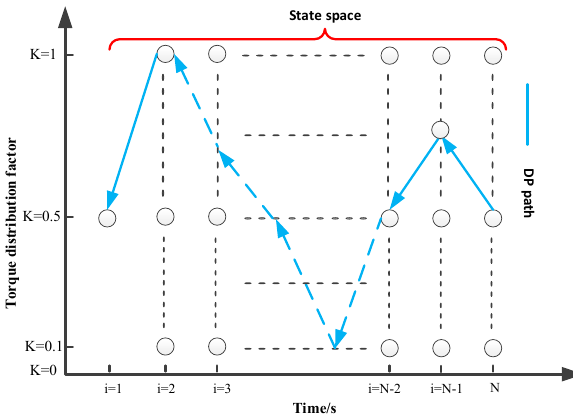
Figure 6. Schematic diagram of dynamic planning control method calculation.